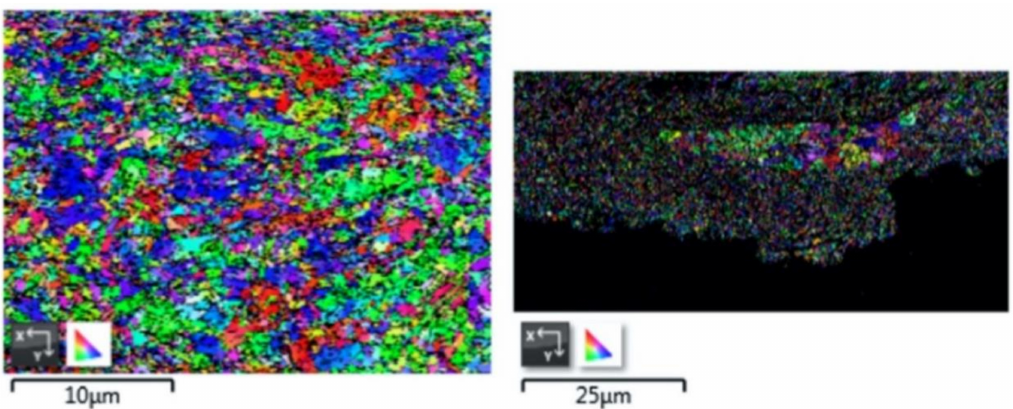
Figure 16. ( Left ) presents the EBSD-derived crystallographic analysis of the conventional cold spray coating in the cross-sectional orientation. ( Right ) presents the EBSD crystallographic analysis of the nanostructured cold spray coating in the cross-sectional